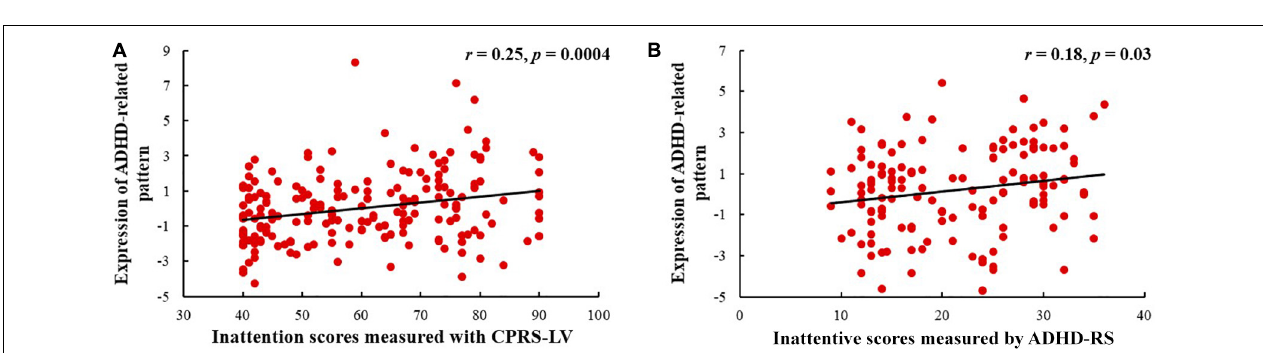
FIGURE 3 | The z-transformed ADHD-related pattern (with |z| > 1) (A) and its expression distribution in the ADHD and TDC groups (the slices displayed from − 15 mm to +80 mm at axis view) (B) . Positive and negative z -values represented increased and reduced GM volumes in the ADHD group than TDC group, respectively. **** p < 0.0001. ADHD, attention deficit hyperactivity disorder; TDC, typically developing control subject.